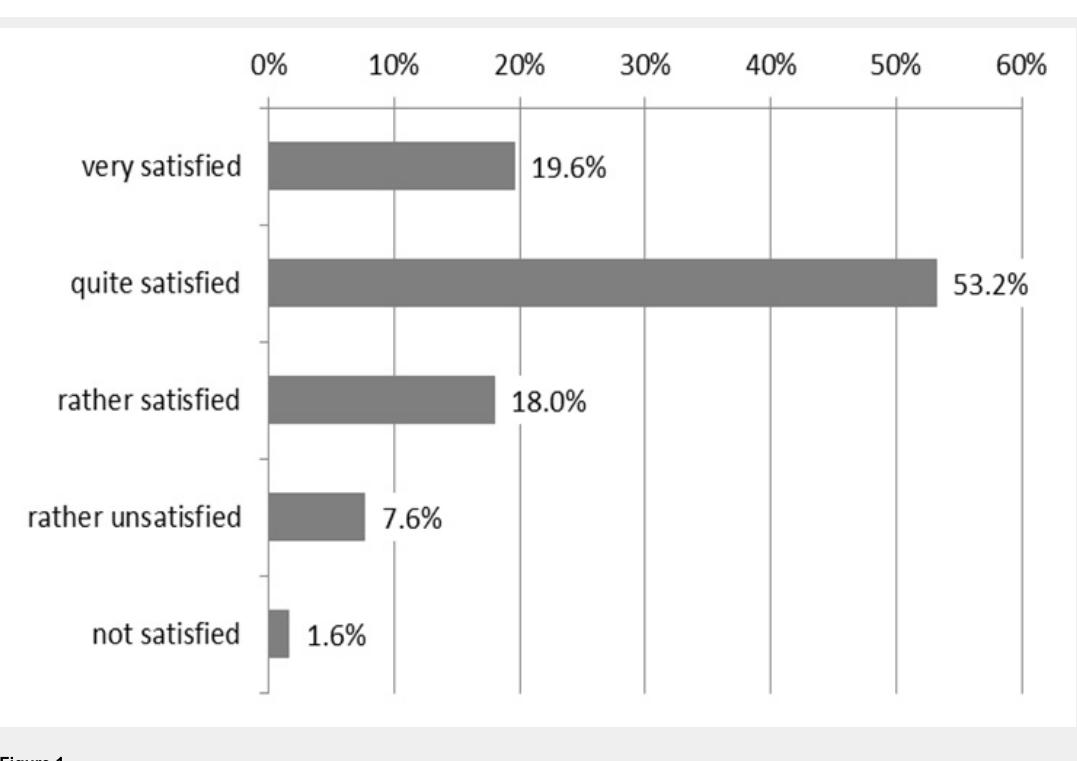
Professional satisfaction of radiologists in